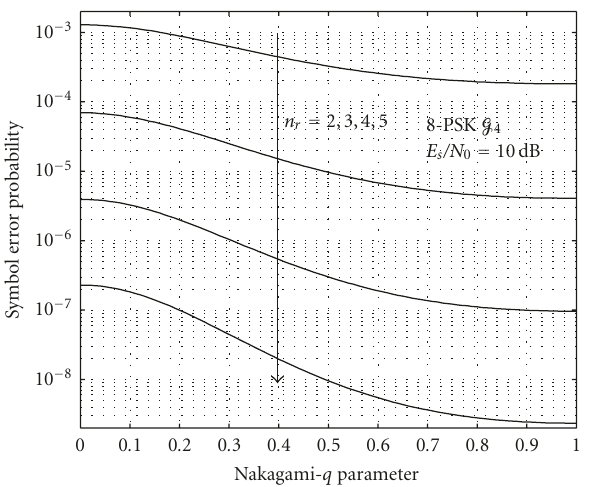
Figure 4: Symbol error probability of 8-PSK G 4 in MIMO Nakagami- q fading channels as a function of the Nakagami- q pa- rameter. n r = 2,3,4,5 and E s /N 0 = 10dB.